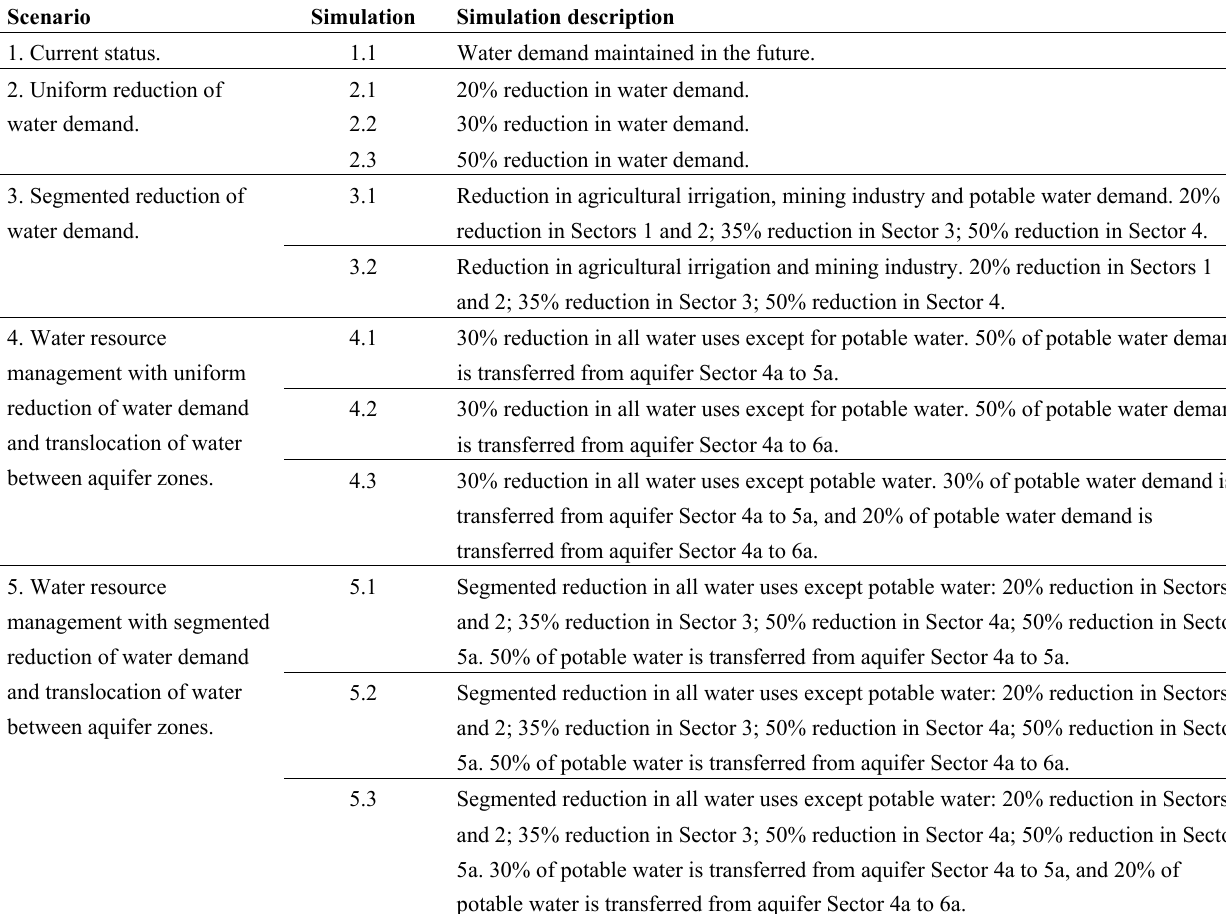
Table 3. Scenarios considered for the integrated water resources management (IWRM)